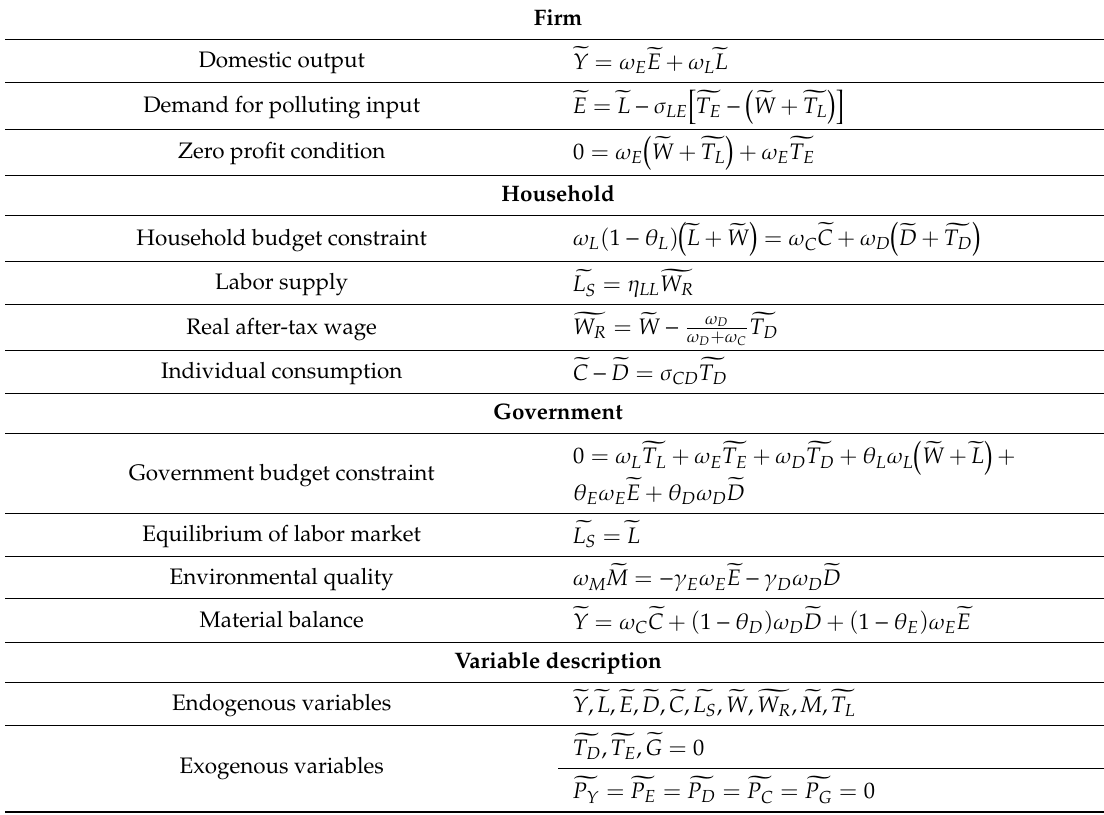
Table 2. Linear logarithm of the